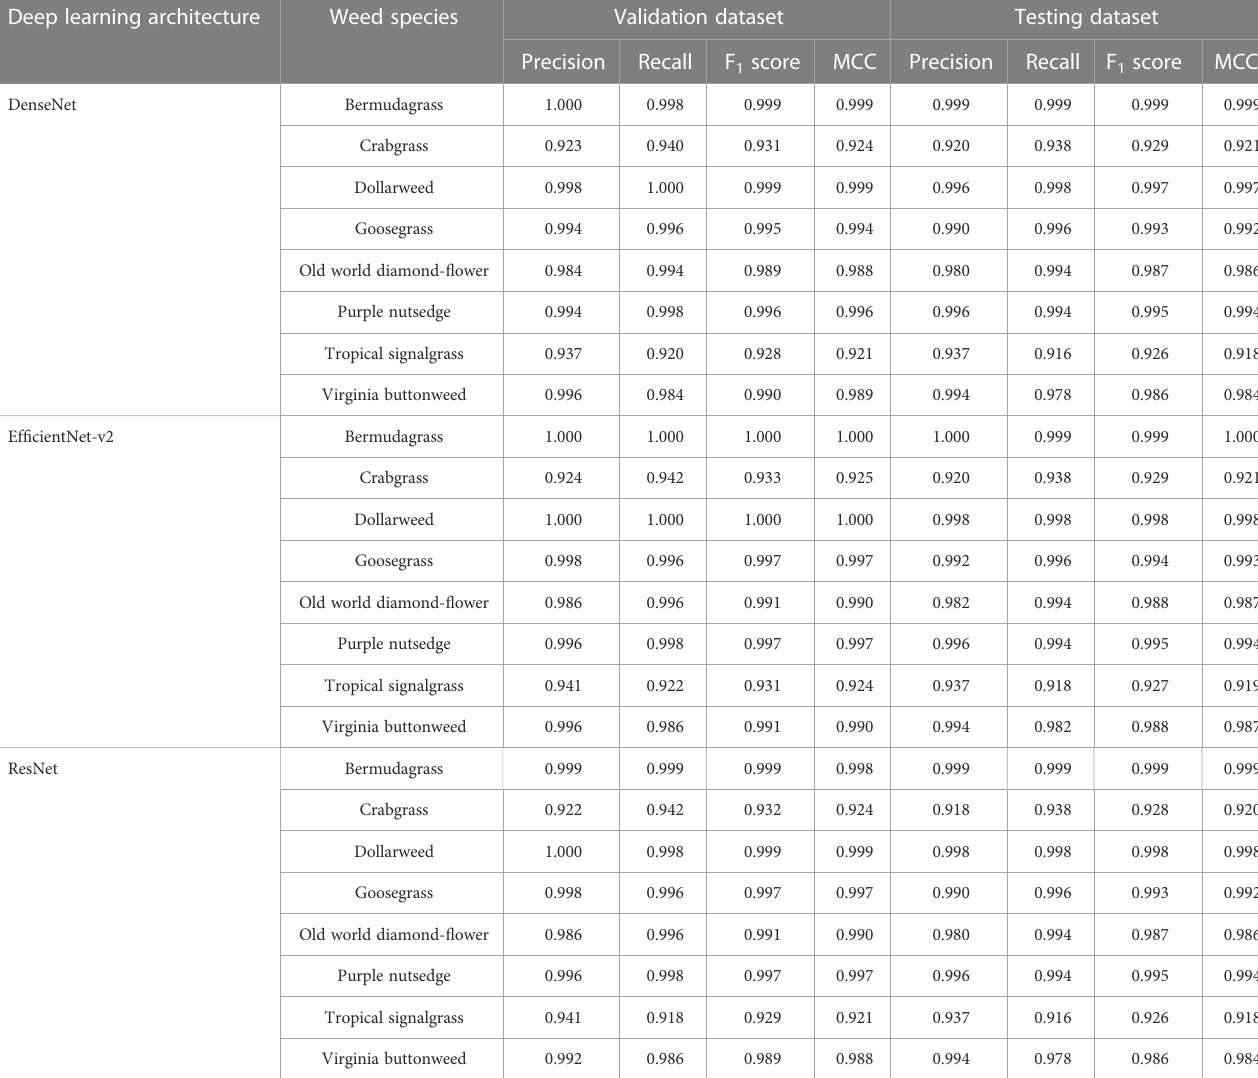
TABLE 3 Weed species detection and discrimination training results using various convolutional neural networks. Deep learning